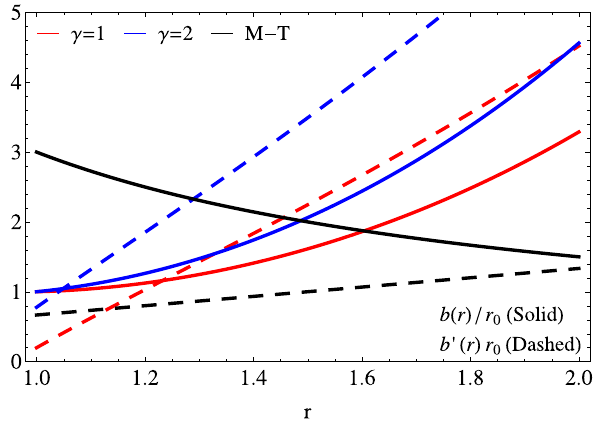
Fig. 2 The trend of the dimensionless shape function b ( r )/ r 0 and the dimensionless flare-out condition b (cid:7) ( r ) r 0 evaluated at the wormhole throat against the radial coordinate r (km), for the model #2. The black curves represent the pure GR counterpart of the model ı.e., the Morris– Thorne (M–T) wormhole space-time. These curves were obtained by using the numerical values provided in Table 5